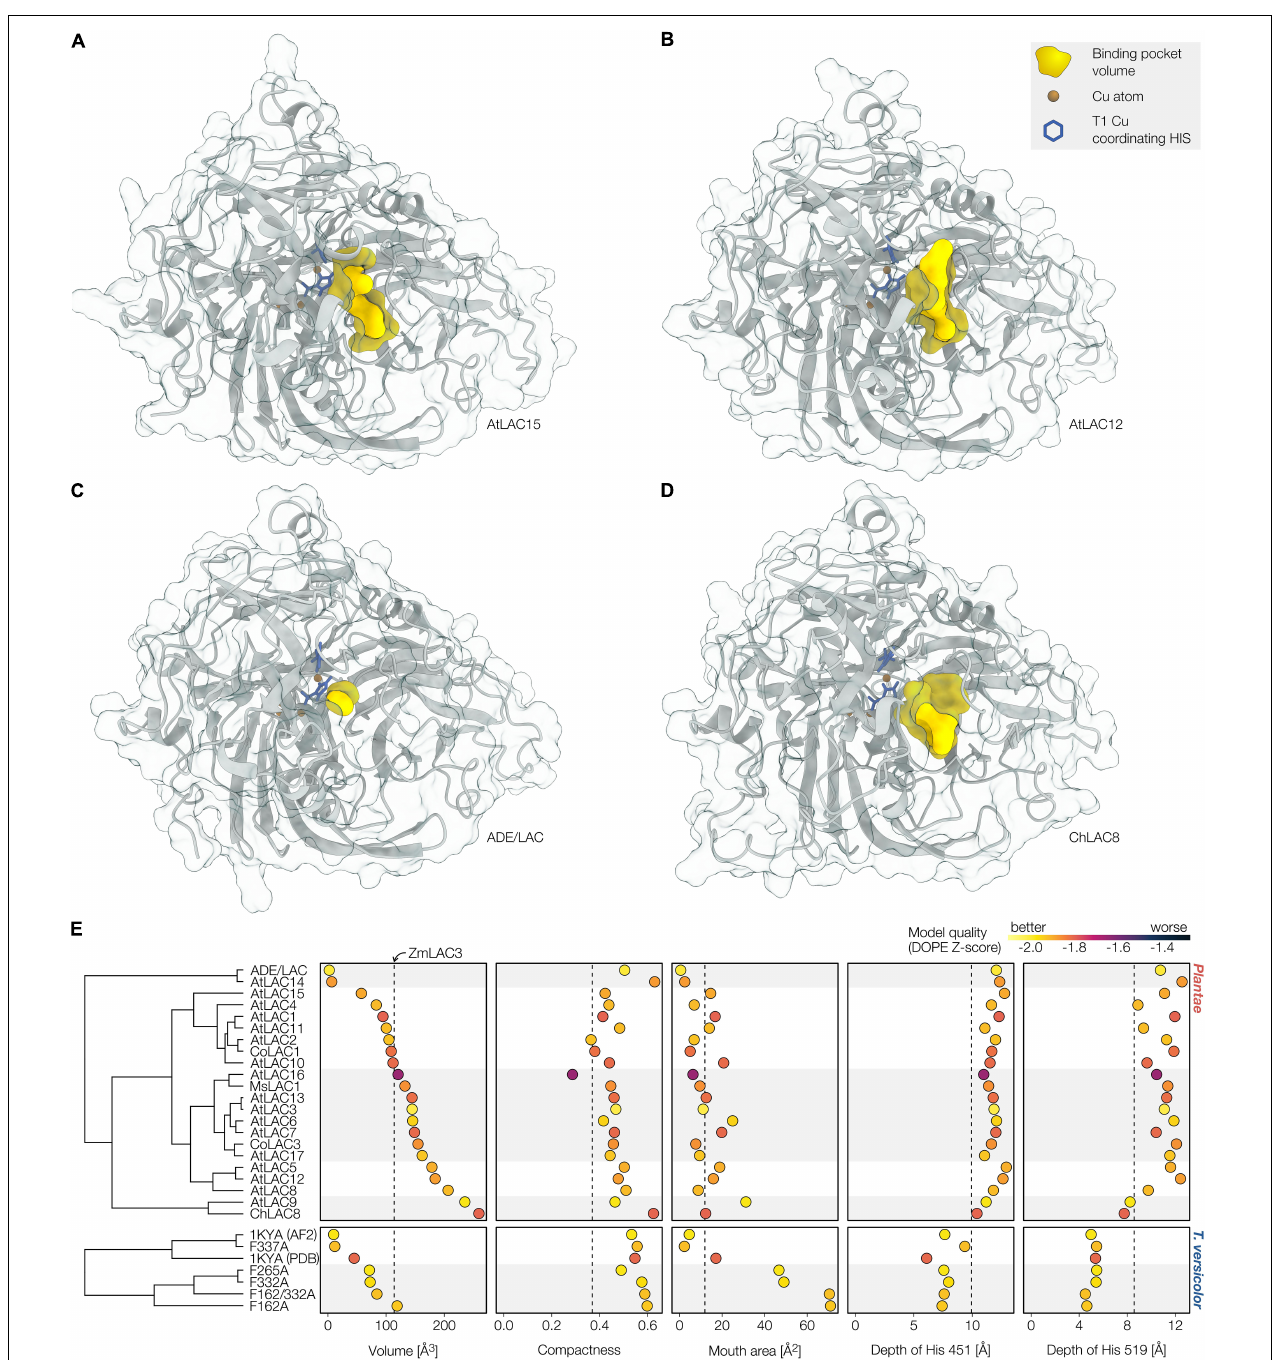
FIGURE 7 | Structural analysis of modelled LAC binding pockets. (A–D) AlphaFold2 structural predictions of AtLAC15, AtLAC12, ADE/LAC, and ChLAC8. The binding pocket volume detected with CASTp is shown in yellow, the copper atoms in brown and the histidines coordinating the T1 copper in blue. (E) Hierarchical clustering of LACs based on the topology of their substrate binding pockets. Pockets were characterised using binding pocket volume, mouth area (the surface area of the yellow pocket volume that is not obscured behind the semi-transparent protein surface) and compactness (pocket volume relative to pocket forming protein surface area), as well as the distance from the protein surface of the two T1 coordinating histidines at the bottom of the pocket (451 and 519 in ZmLAC3). The results for the binding pocket from the crystal structure of ZmLAC3 are indicated by a dashed line. The quality of each individual model is colour coded, where values below –1.2 indicate native-like models. Trametes versicolor LacIIIb (PDB identifier 1KYA) was included for validation, showing expected increases in binding pocket size and mouth area in the targeted mutagenesis LacIIIb versions F265A, F332A, F162A, and F162A/F332A but not in F337A. PDB, crystal structure from the protein database; AF2, AlphaFold 2